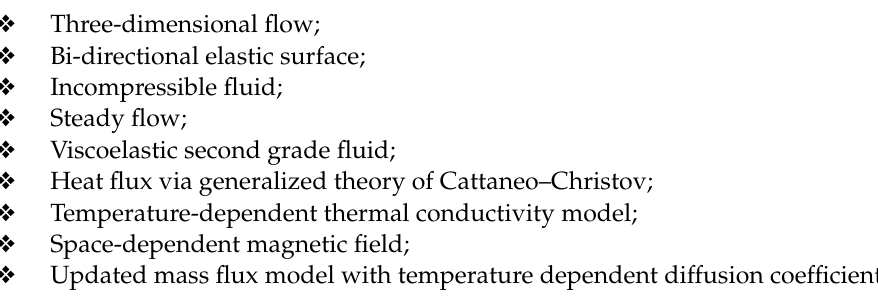
Figure 1. Geometry of second grade fluid